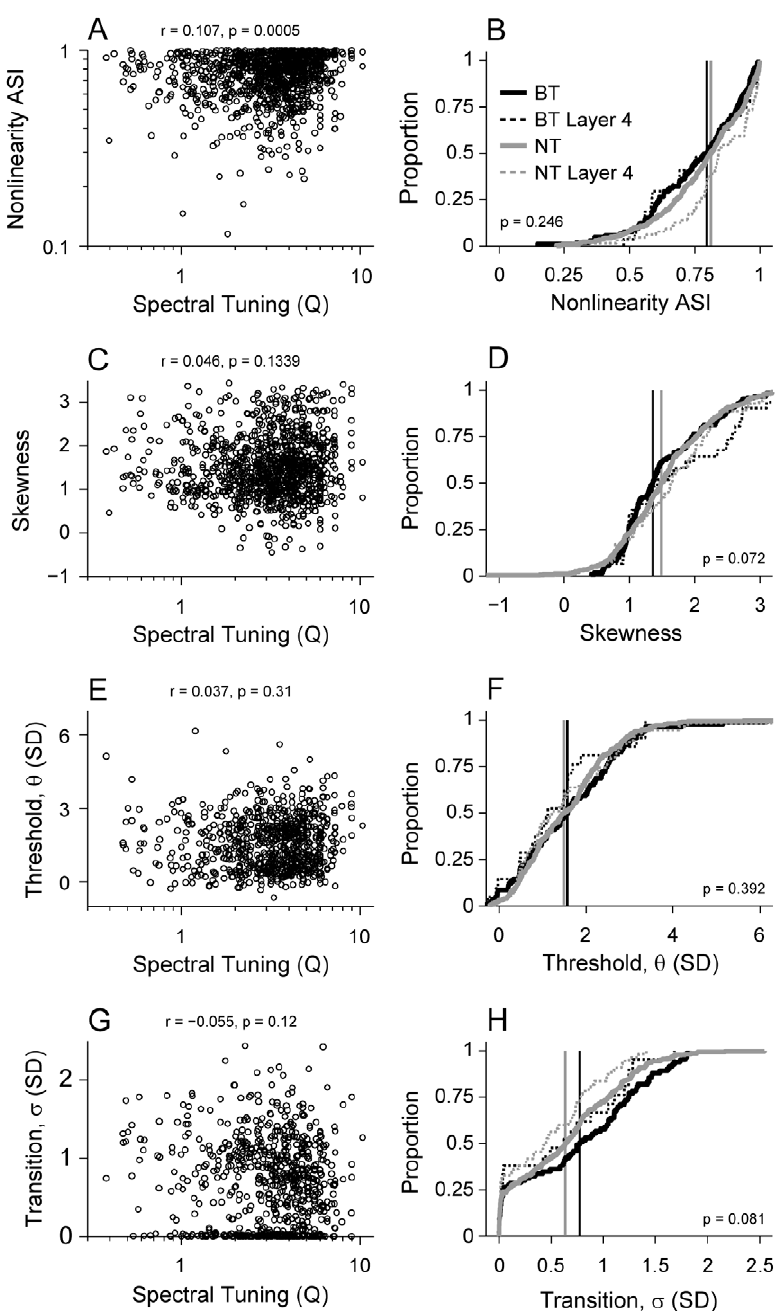
Figure 12. Nonlinearity parameters versus spectral tuning (Q). (A) Nonlinearity asymmetry index (ASI) was weakly correlated with increasing Q (r=0.107, p , 0.001, t-test). (B) BT and NT neurons had similar ASI distributions. Solid lines represent population data. Vertical lines indicate population medians (BT median=0.79, NT median=0.81, p=0.246, KS-test). Dashed lines represent values for neurons in layer 4 (800–1100 m m). (C) Nonlinearity skewness was not significantly correlated with Q (r=0.046, p=0.134, t-test). (D) Skewness was significantly different for BT and NT neurons (BT median=1.36, NT median=1.49, p=0.072, KS-test). (E) Nonlinearity threshold, h , was not correlated with Q (r=0.037, p=0.31, t-test). (F) Threshold was similar for BT and NT neurons (BT median=1.57, NT median=1.49, p=0.392, KS-test). (G) Nonlinearity transition noise, s , was not correlated with Q (r= 2 0.055, p , 0.12, t-test). (H) Nonlinearity transition was similar for BT and NT neurons (BT median=0.77, NT median=0.64, p=0.081, KS-test).